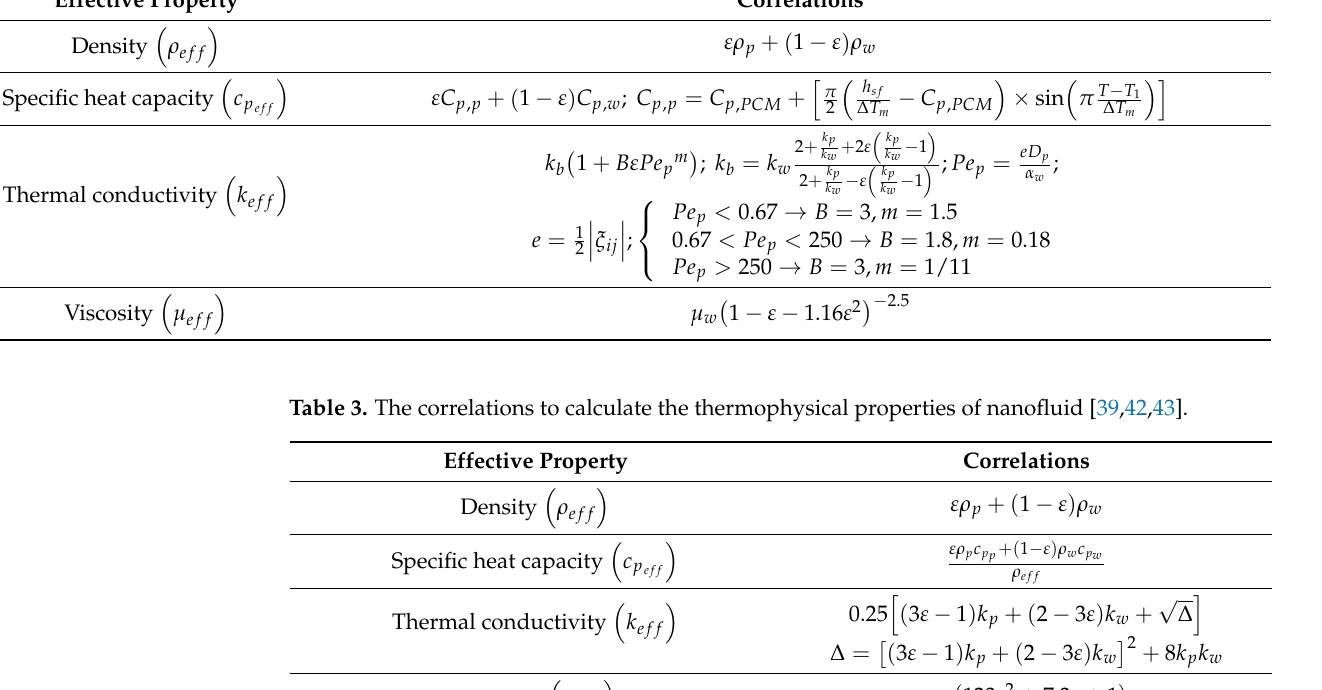
Table 2. The correlations to calculate the thermophysical properties of NEPCM slurry [40,41]. Effective Property